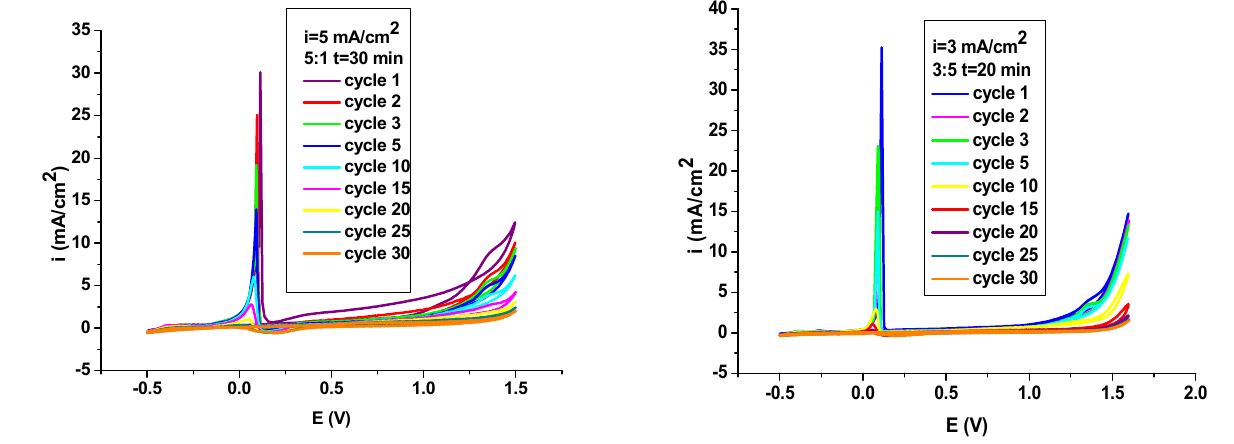
Figure 2. Potentiostatic depositions of PNMPY-TW20/P3MT OLC 45 at potential 1.2 V ( a ) and 1.4 V ( b ) vs. SCE for 1200-1800 s with different molar ratio for PNMPY-TW20 and P3MT. 3.2. Electrochemical Characterization of PNMPY-Tw20/P3MT Composite Coating The electrochemical behavior of the PNMPY-TW20/P3MT composite covered on the OLC 45 sample in 0.3 M H 2 C 2 O 4 solution without a monomer is displayed in Figure 3 in